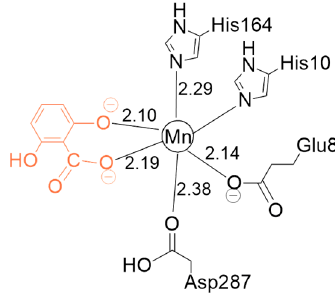
Figure 13. Scheme representing the coordination environment around the Mn 2+ cation with resorcylate anion in a bidentate chelating coordination mode. Adapted with permission from [54]. Copyright 2018, American Chemical Society.